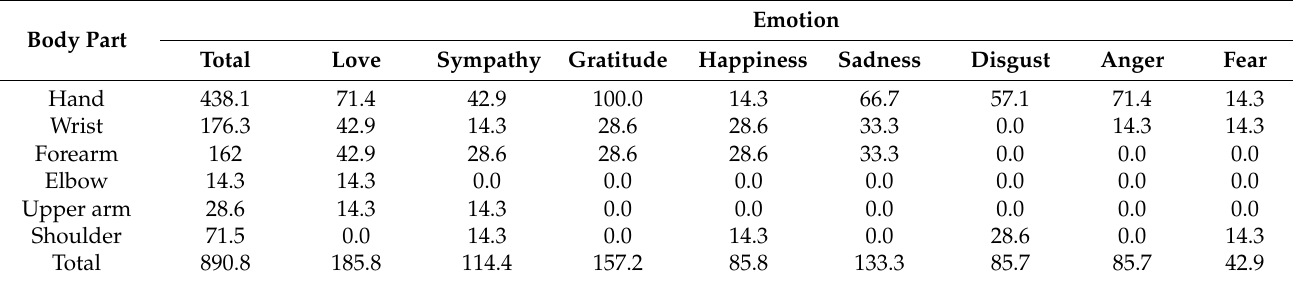
Table 2. Contact zones of the robot, as described in Figure 3b, that participants touched to express their emotions (unit: